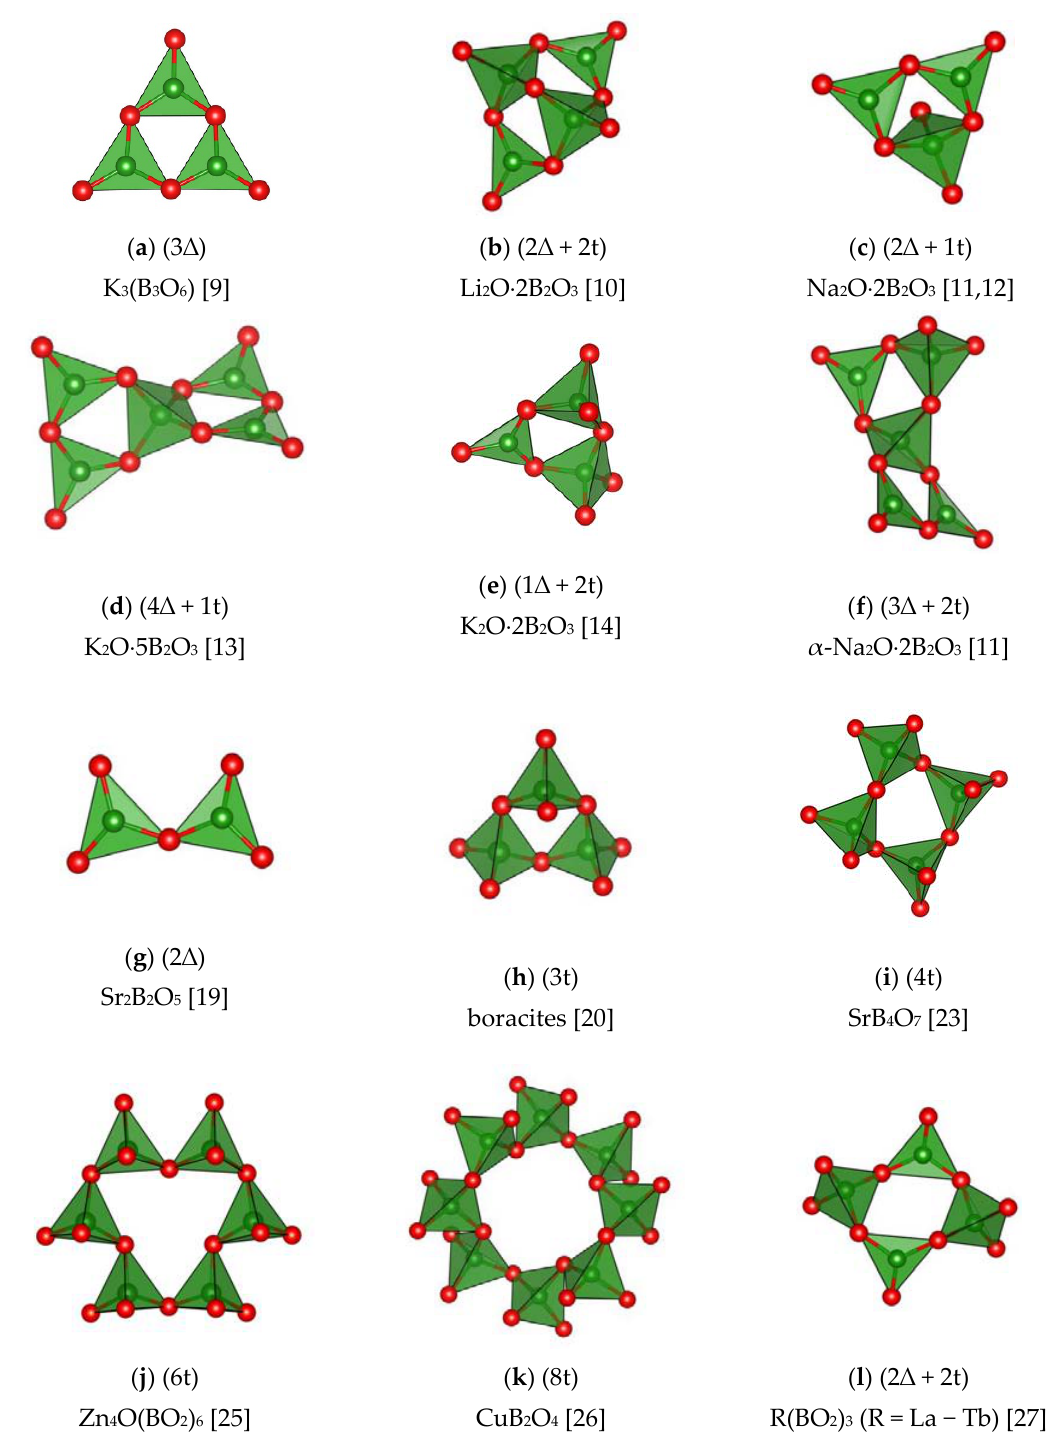
Figure 3. Examples of CSU in mono-, di- and trivalent metal simple (monocationic) borates (the green and red balls represent B, and O atoms, respectively). ( a ) K 3 (B 3 O 6 ) [9]; (b) Li 2 O · 2B 2 O 3 [10]; ( c ) Na 2 O · 2B 2 O 3 [11,12]; ( d ) K 2 O · 5B 2 O 3 [13]; ( e ) K 2 O · 2B 2 O 3 [14]; ( f ) α -Na 2 O · 2B 2 O 3 [11]; ( g ) Sr 2 B 2 O 5 [19]; ( h ) boracites [20]; ( i ) SrB 4 O 7 [23]; ( j ) Zn 4 O(BO 2 ) 6 [25]; ( k ) CuB 2 O 4 [26]; ( l ) R(BO 2 ) 3 (R = La − Tb) [27]